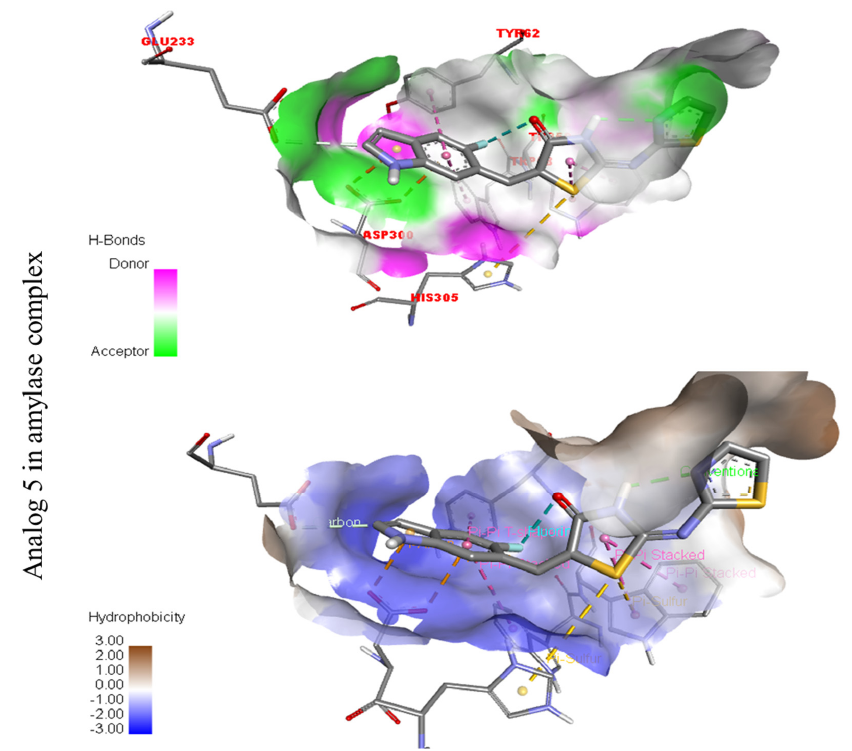
Figure 7. Represent hydrogen bond and hydrophobic character against Alpha-amylase indicate the PLI profile for compound 5 .